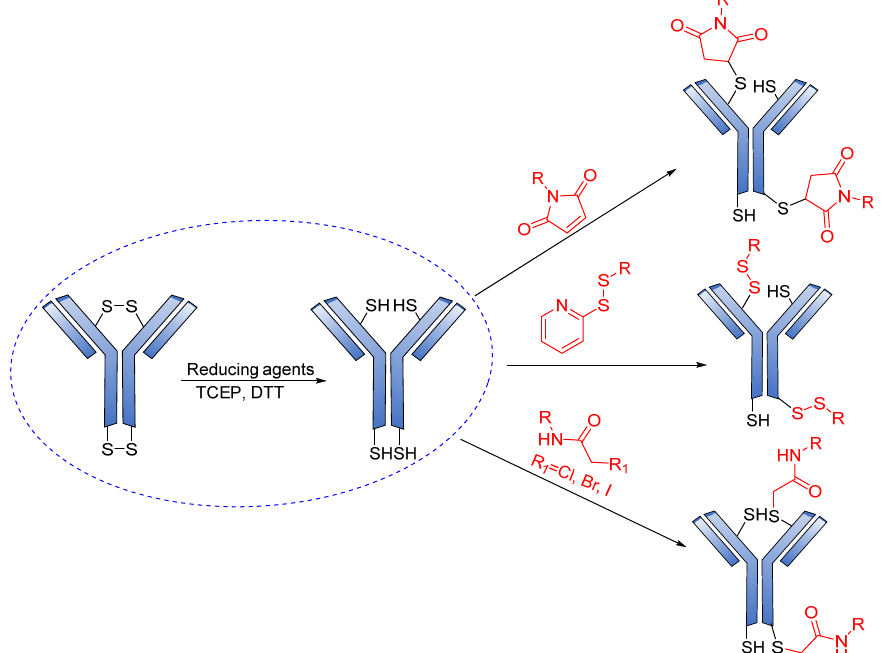
Figure 18. Mechanism for the formation of the sulfyhydryl attachment site.